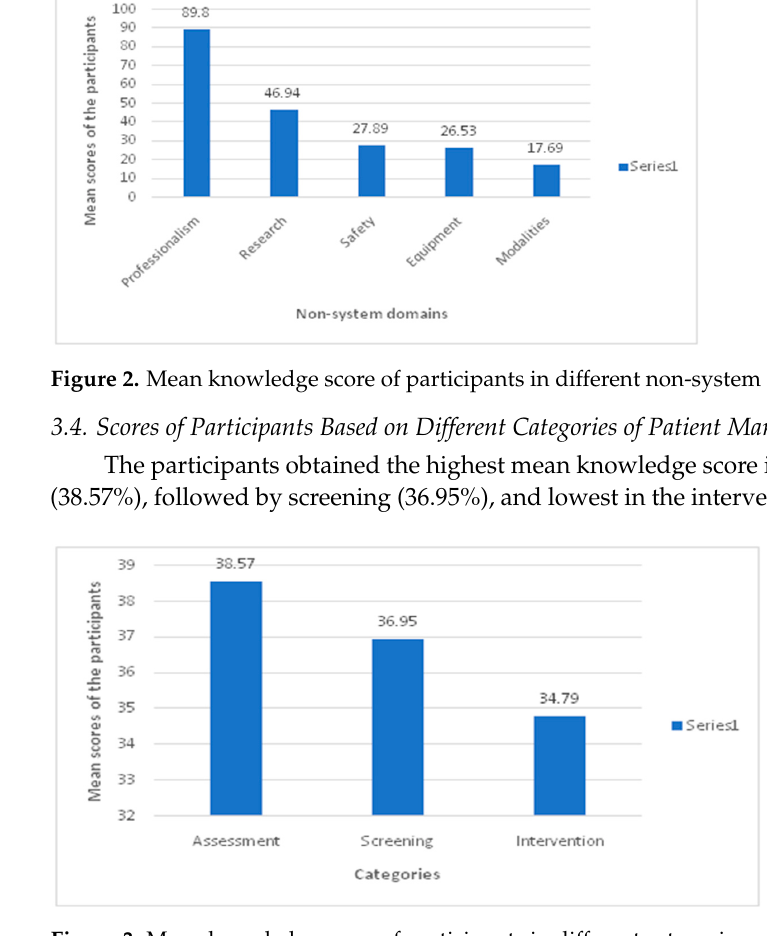
Figure 1. Mean knowledge score of participants in different domains of the body system.